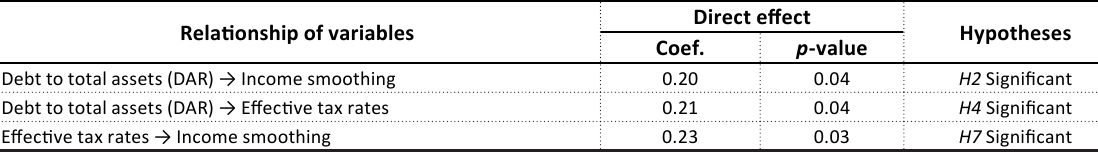
Table 5. Hypotheses testing results of indirect